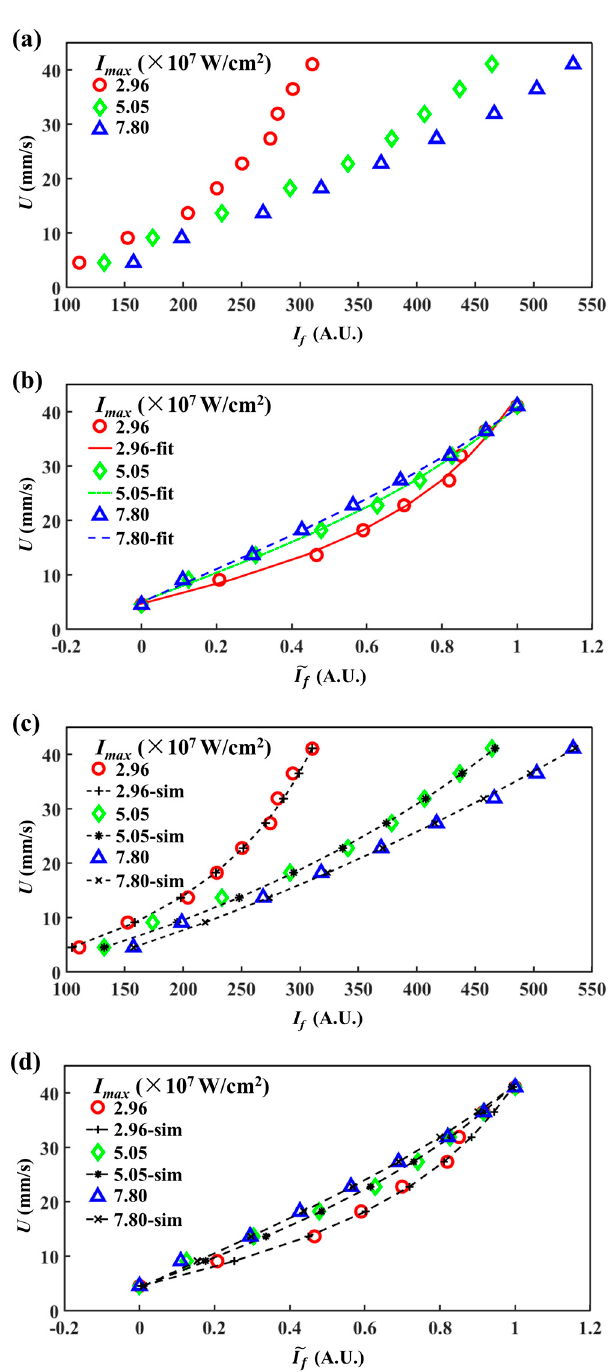
Figure 3. LIFPA velocity calibration curves. ‘fit’ and ‘sim’ represent the fitting and simulation calibration curves, respectively. ( a ) Experimental calibration curves for different laser power densities at center of the microchannel; ( b ) normalization for ( a ); ( c ) comparison of experimental and simulated calibration curves; ( d ) normalization for ( c ).